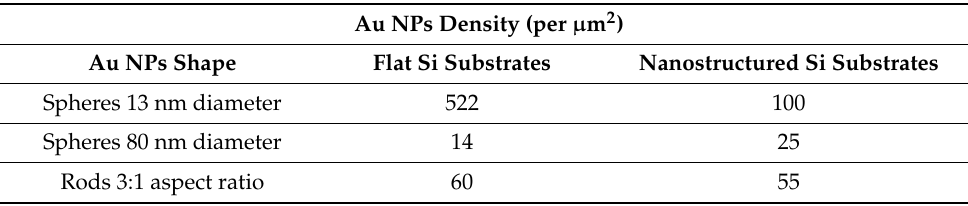
Table 1. Au NPs’ density distribution on both flat and nanostructured Si substrates (per um 2